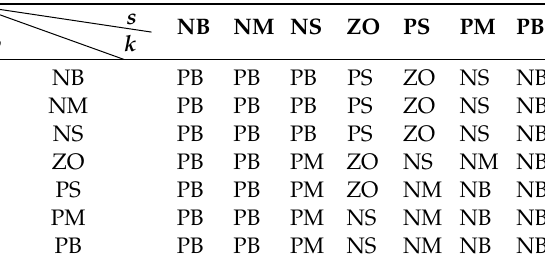
Table 3. Rule base of k.